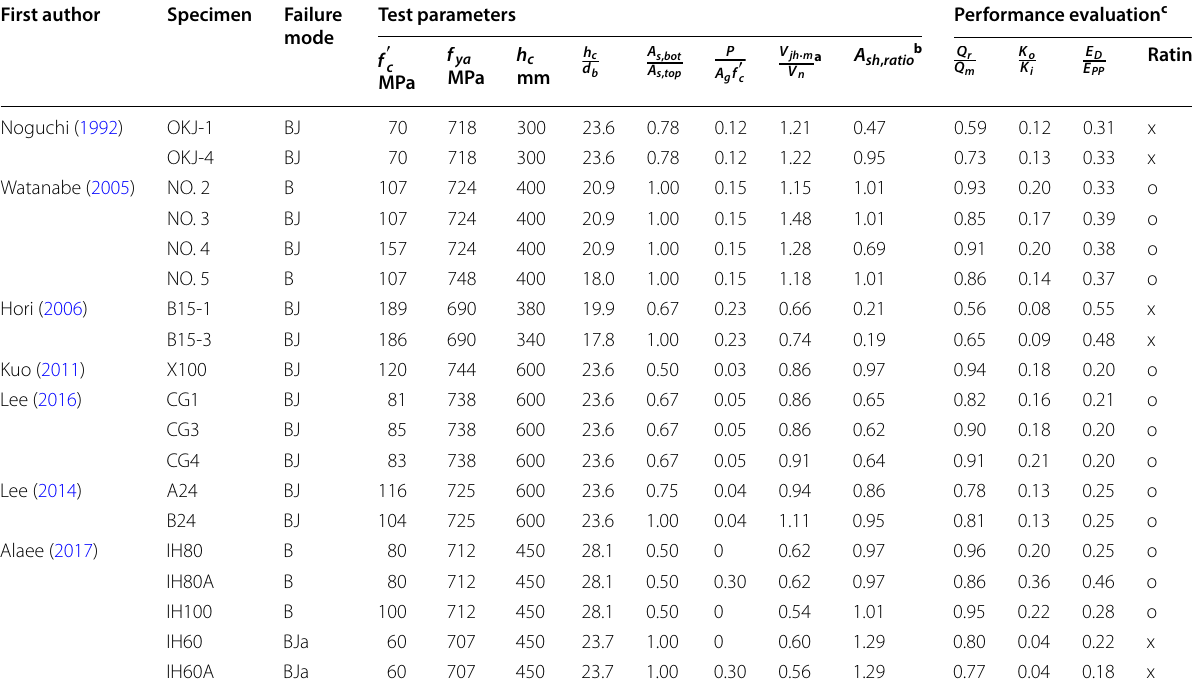
Failure mode: “B”, beam flexural failure; “BJ”, Beam yielding followed by Joint shear failure; “BJa” Beam yielding followed by Joint anchorage failure. a Experimental-to-nominal joint strength ratio per ACI 318.